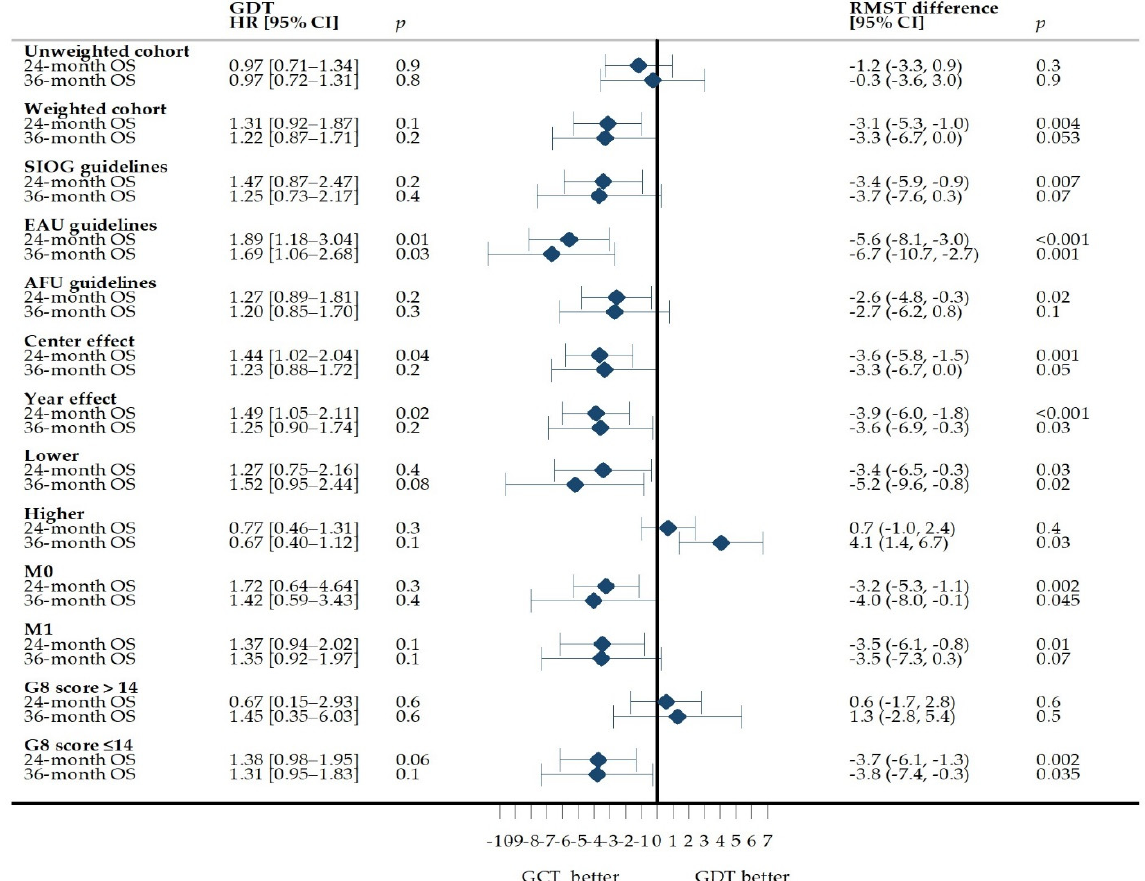
Figure 3. Association of GDT with 24- and 36-month overall survival and intergroup differences in OS before and after SIPTW. The difference in RMST is expressed in months. A negative RMST difference corresponds to a shorter survival time in the GDT group than in the GCT group. A specific pseudopopulation was generated using SIPTW for all cohorts other than the unweighted cohort. None of the HR estimations satisfied the proportional hazards assumption. AFU: French Association of Urology, EAU: European Association of Urology, GCT: guideline–concordant treatment, GDT: guideline–discordant treatment, Higher: higher-intensity treatment, HR: hazard ratio, Lower: lower-intensity treatment, M0: non-metastatic disease, M1: metastatic disease, SIOG: International Society of Geriatric Oncology, SIPTW: standardized inverse probability of treatment weights.